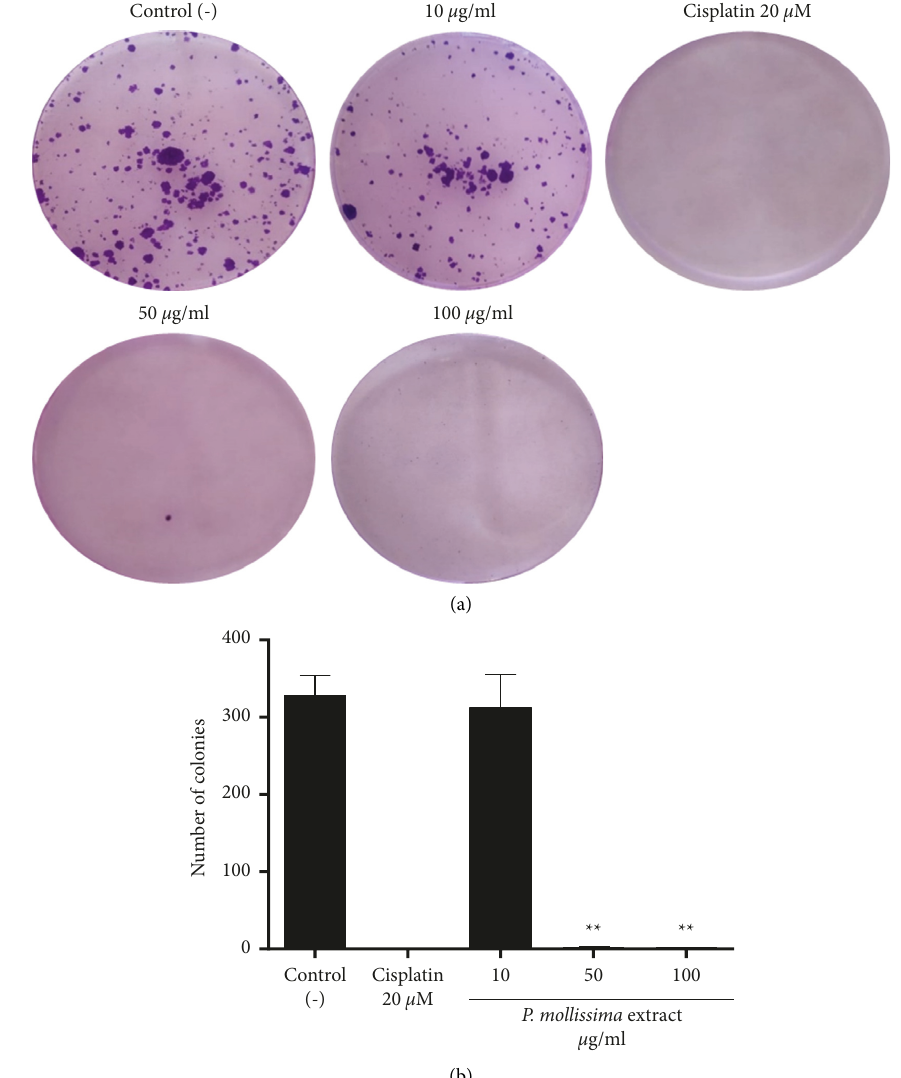
Figure 7: The inhibitory effects of PME and Cisplatin on cell colony formation in CAL 27 spheroids. (a) Representative dishes by colony- forming assay (b) Inhibitory effect of PME (10, 50, and 100 μ g/ml) and cisplatin 20 μ M on cell proliferation in CAL-27 spheroids and the influence of oral cancer cells on the number of colony-forming cells at 72hours. The results shown are representative of three independent experiments. ∗∗ p < 0.05, control versus PME-treated